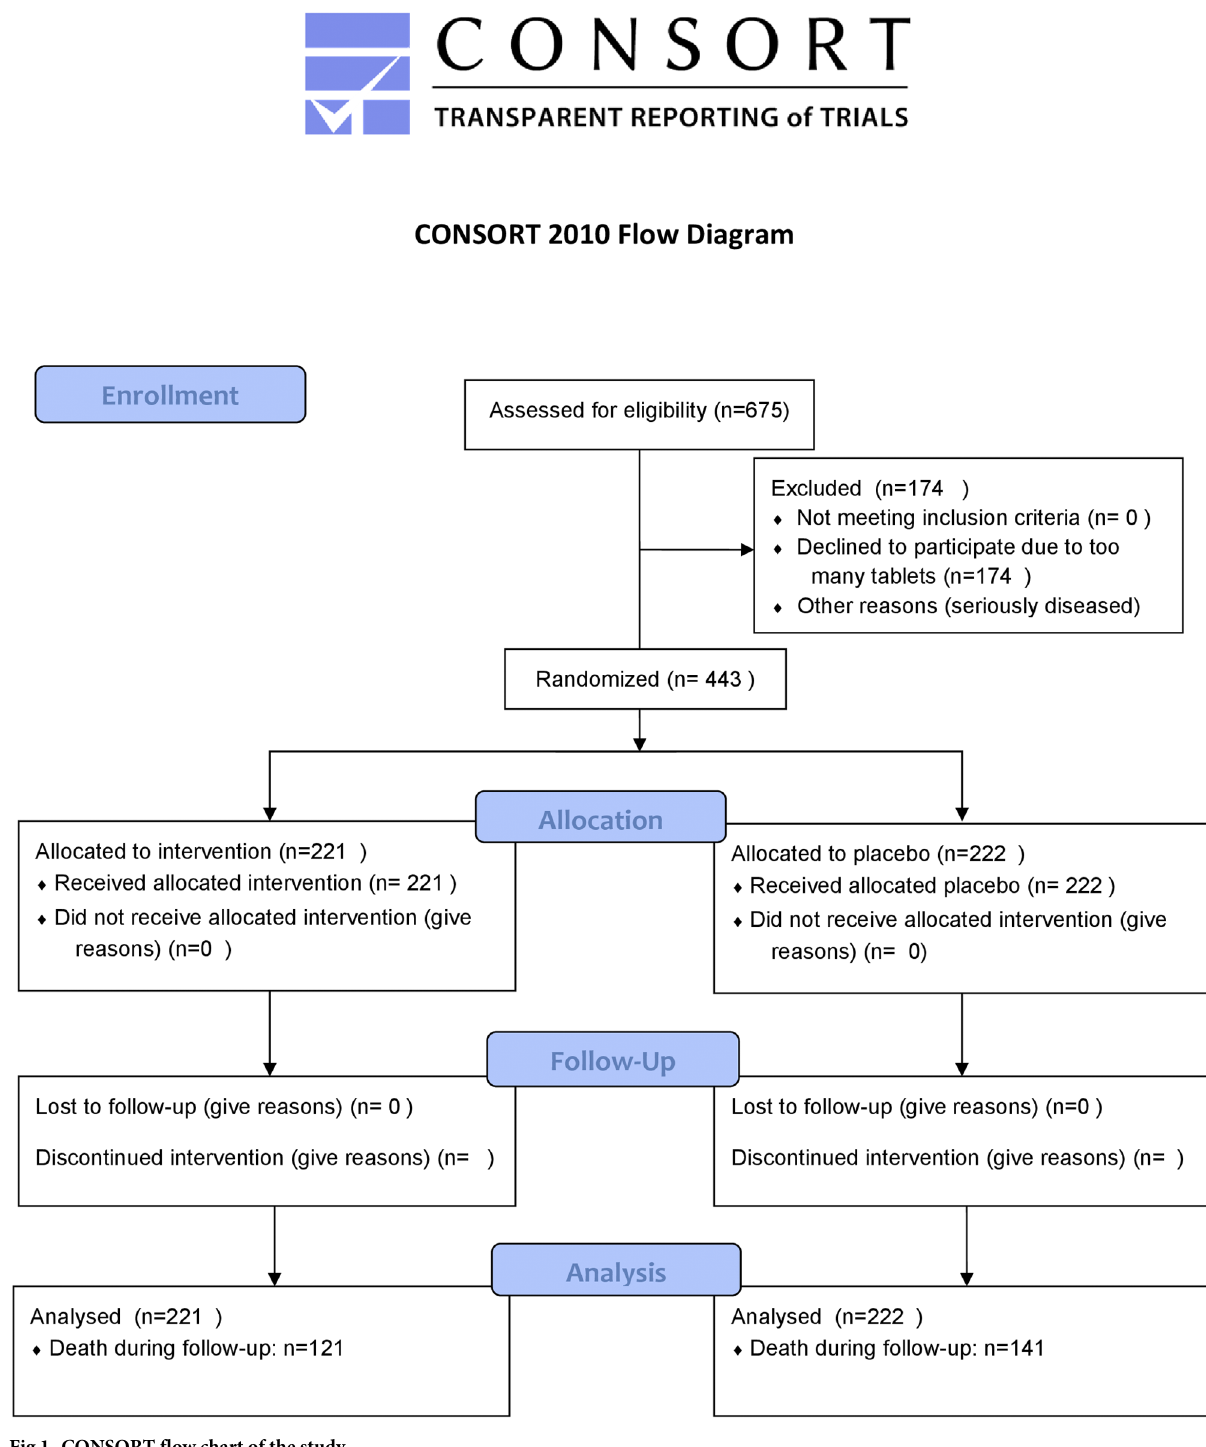
Fig 1. CONSORT flow chart of the study.